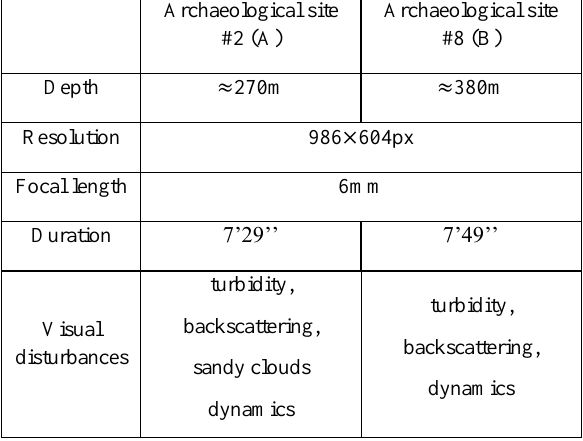
Table 1. Data description of archaeological site #2 and #8